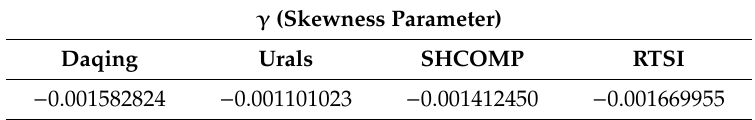
Table A20. MNIG Skewness parameter γ for Vector 5: Daqing, Urals, SHCOMP, RTSI.